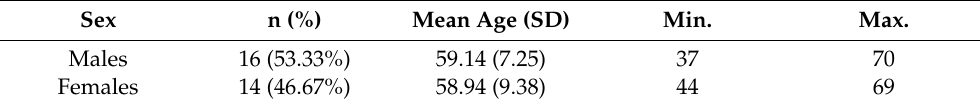
Figure 2. CONSORT flow chart of the study showing enrollment and allocation procedures. Table 3. Demographic data of the study sample at the baseline (T0).